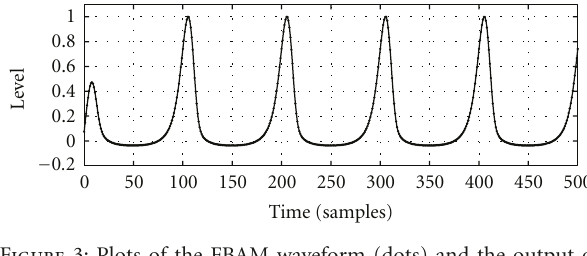
Figure 3: Plots of the FBAM waveform (dots) and the output of its equivalent time-varying filter of (20) (solid), when fed with a sinusoid ( f 0 = 441Hz).